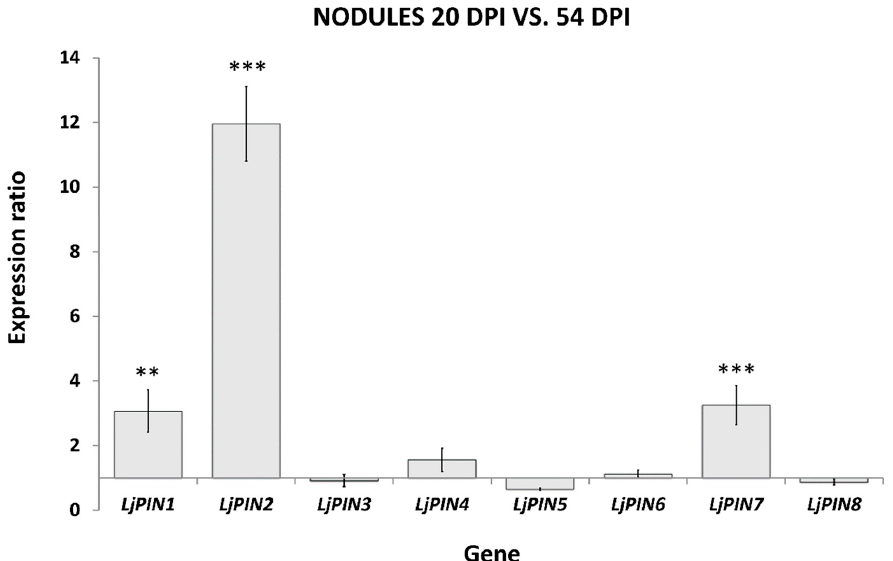
Figure 2. Relative expression levels of LjPINs in root nodules 20 dpi in comparison to the nodules 54 dpi. The expression values for nodules 54 days post rhizobial inoculation (dpi) were set as unity for each tested gene and the expression level in nodules 20 dpi was proportionally converted. Mean